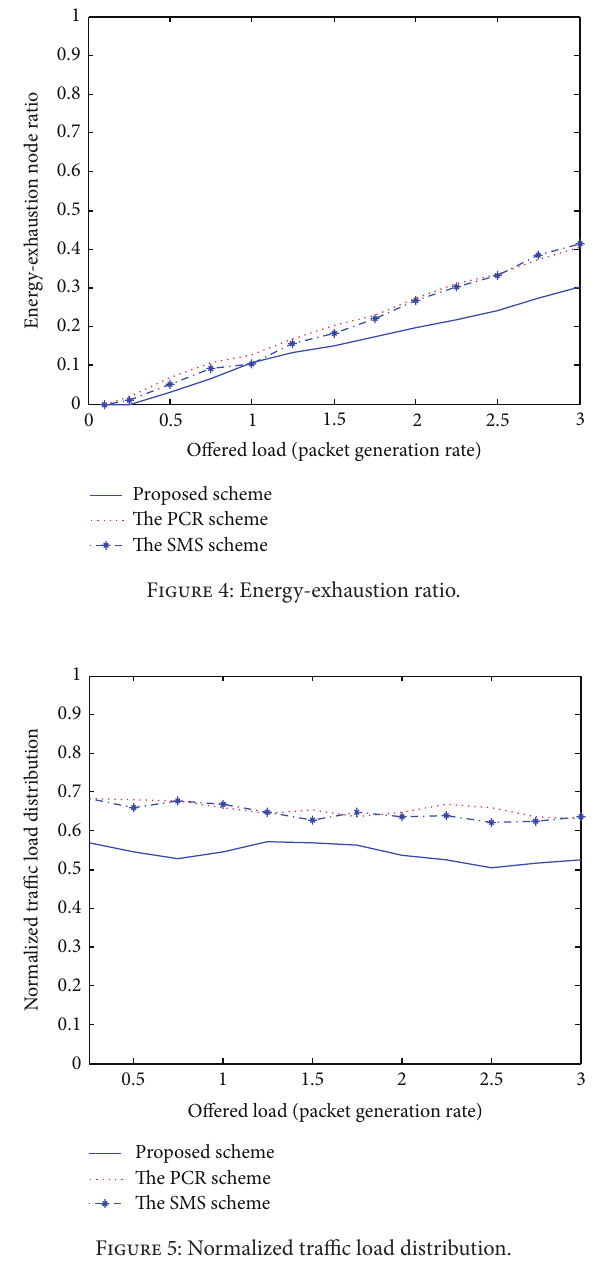
Figure 5: Normalized traffic load